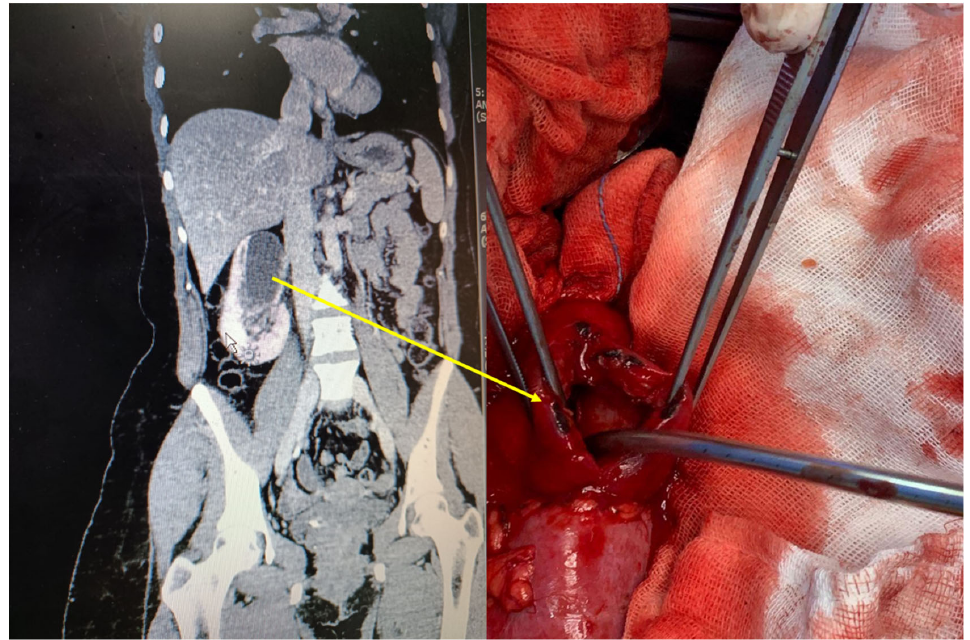
Figure 3. Features of RPN in Fraley syndrome. This is a histologically confirmed case of RPN after partial nephrectomy. The CT scan denotes the upper pole obstruction with hydrocalycosis as de ‐ picted by the arrow. The per ‐ operative findings image post excision are also shown.